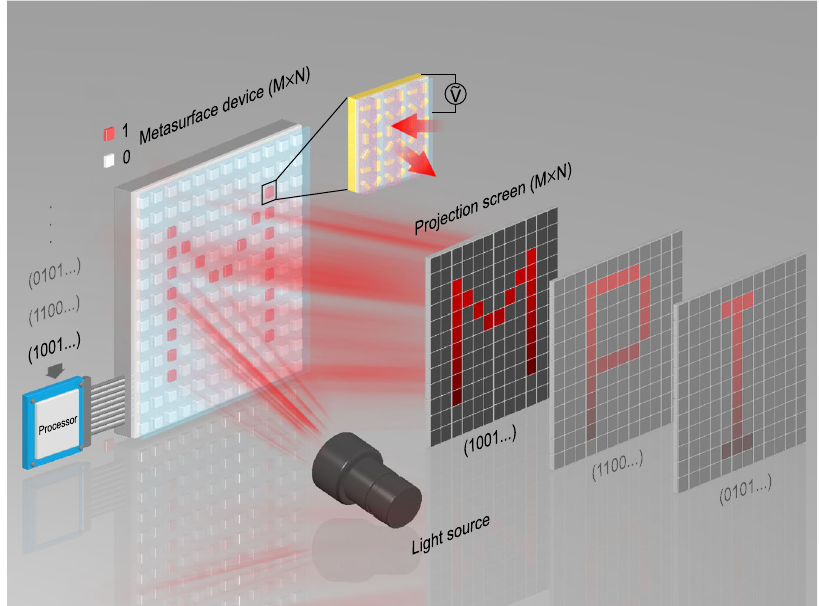
Fig. 1 Digital metasurface device (DMSD) for light projection displays. The DMSD comprises metasurface pixels in an M × N array. Each metasurface pixel contains gold nanorods arranged in a rectangular lattice. The preselected columns are covered with a dielectric material. The sample is encapsulated in a thin liquid crystal (LC) cell. The intensity of the anomalous re fl ection from each metasurface pixel is controlled by an addressable electrode and can be independently switched on and off. Programmable images (M × N resolution) are dynamically displayed in the far fi